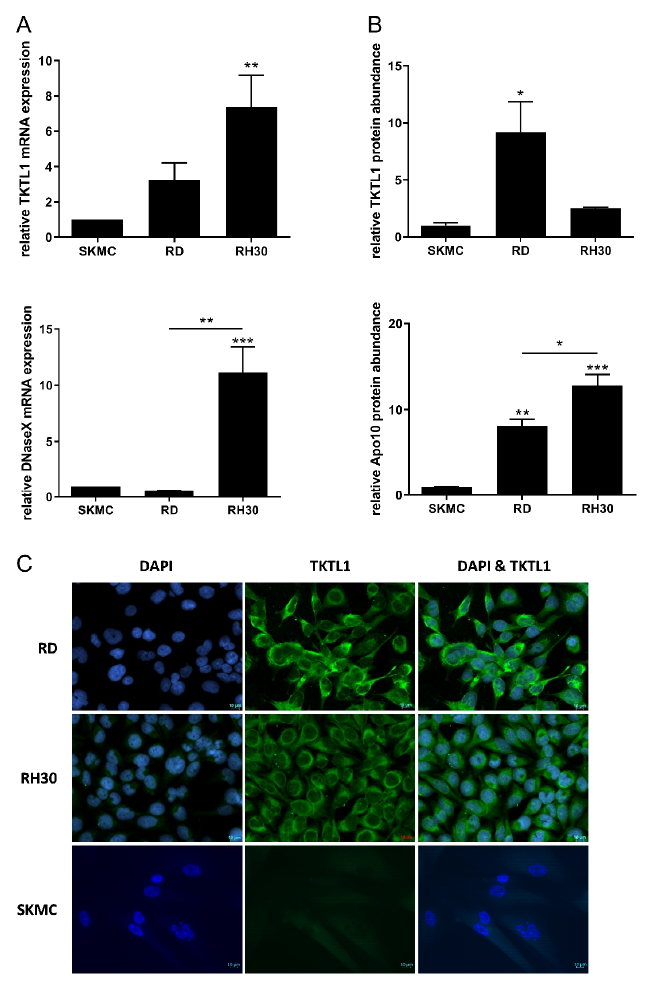
Figure 1. Expression of TKTL1 and DNaseX/Apo10 in RMS cell lines. Transcriptional expression of TKTL1 (upper graph) and DNaseX/Apo10 (lower graph) in the RMS cell lines RD and RH30, as well as in the SKMC cell line ( A ). TKTL1 and Apo10 protein abundance in RD, RH30, and SKMC cells ( B ). The expression levels in the figure are relative values. TKTL1 and Apo10 mRNA levels were measured by quantitative real time RT-PCR, with TBP as housekeeping gene. The data are presented as mean +/ − standard error (SEM), n = 4; * p < 0.05; ** p < 0.01; *** p < 0.001 indicate statistical significance to SKMCs (ANOVA, Bonferroni correction). ( C ) Representative immunofluorescence staining and fluorescence microscopy of intracellular staining of TKTL1 (green) and DAPI for nuclei (blue) in RD, RH30, and SKMC cells. Original magnification, 40 ×